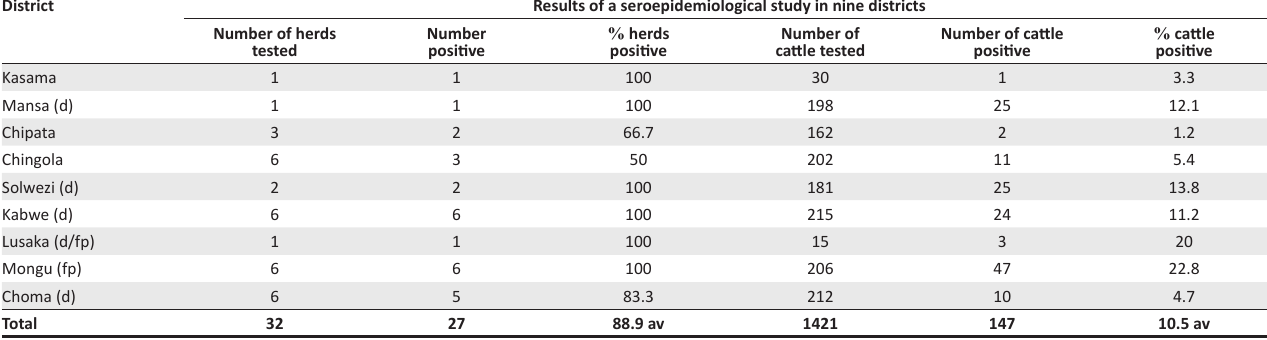
FIGURE 2: Map of Zambia showing sampling location denoted with square dots. TABLE 1: Distribution of Rift Valley fever amongst cattle in Zambia.